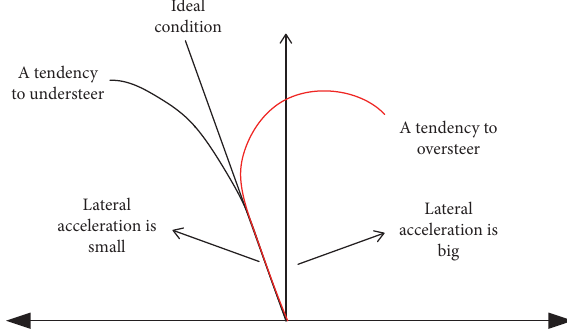
Figure 5: Rutted road model and risk levels.